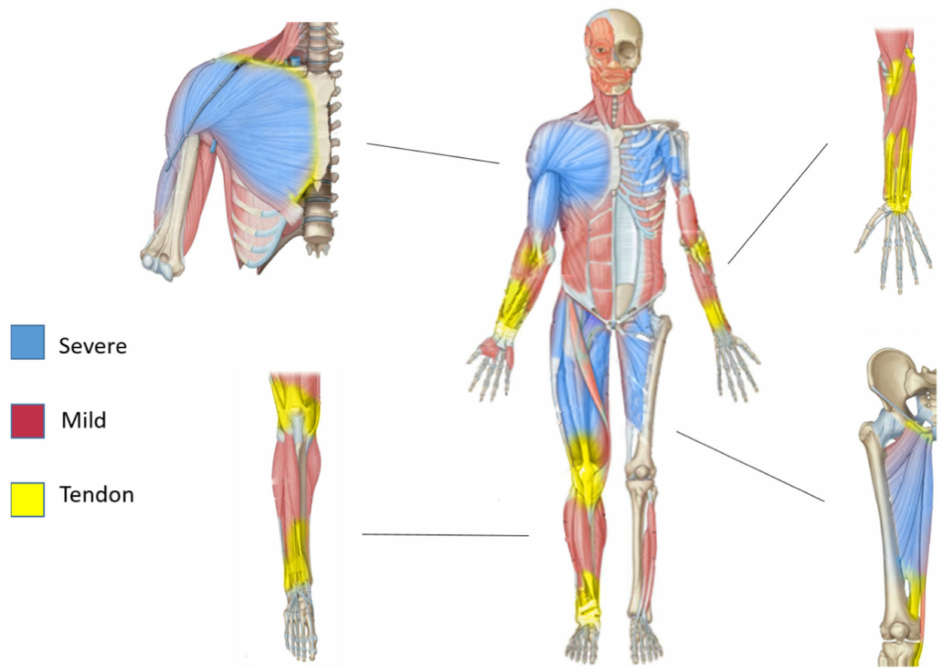
Figure 3. Proximo-distal pattern of muscles affected in sarcoglycanopathies and proximo-distal pattern in tendon architec- ture. Schematic presentation of human sarcoglycanopathy-affected muscle pattern with the magnification of